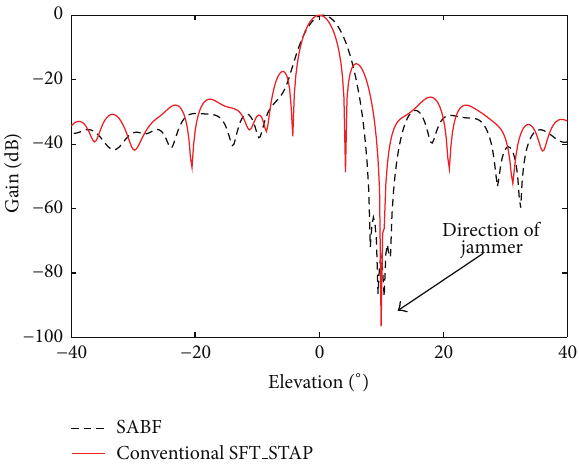
Figure 3: Adapted pattern obtained with subarrayed broadband ABF.